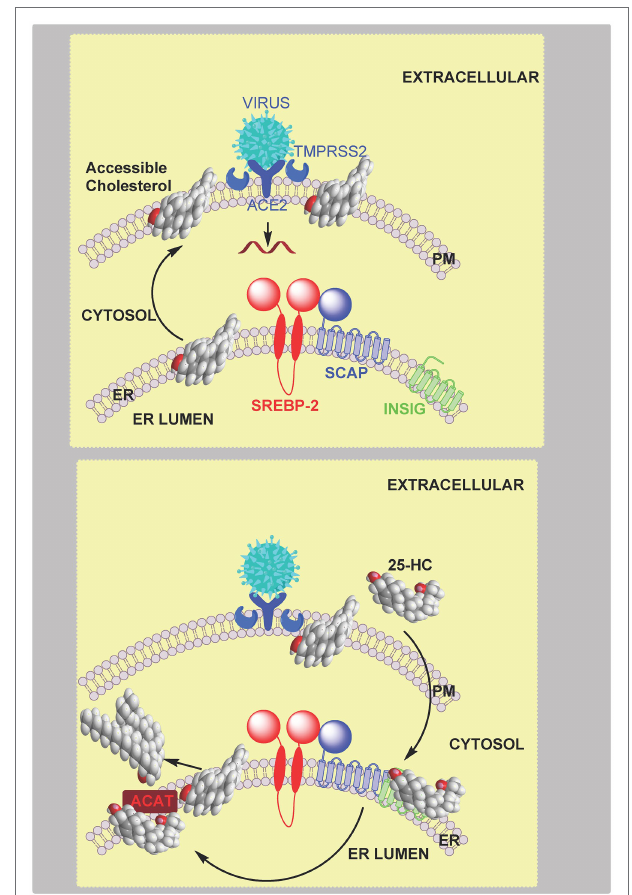
FIGURE 12 | Model of coronavirus entry via the early pathway. Upper panel , virus binds to the cell surface ACE2 receptor. The membrane-bound TMPRSS2 enzyme triggers the early fusion pathway by proteolytic cleavage of the spike protein to induce the fusion-competent state of the protein. Membrane fusion proceeds and results in release of viral RNA into the cytoplasm. Membrane fusion is dependent on sufficient accessible cholesterol in the plasma membrane. Lower panel , 25-HC inhibits membrane-fusion and replication. This is achieved by reducing accessible cholesterol in the plasma membrane. Data from Wang et al. (2020) indicate that this is achieved by activating the endoplasmic reticulum enzyme ACAT/SOAT which esterifies cholesterol. An alternative explanation is 25-HC binding to INSIG and reducing cholesterol biosynthesis and